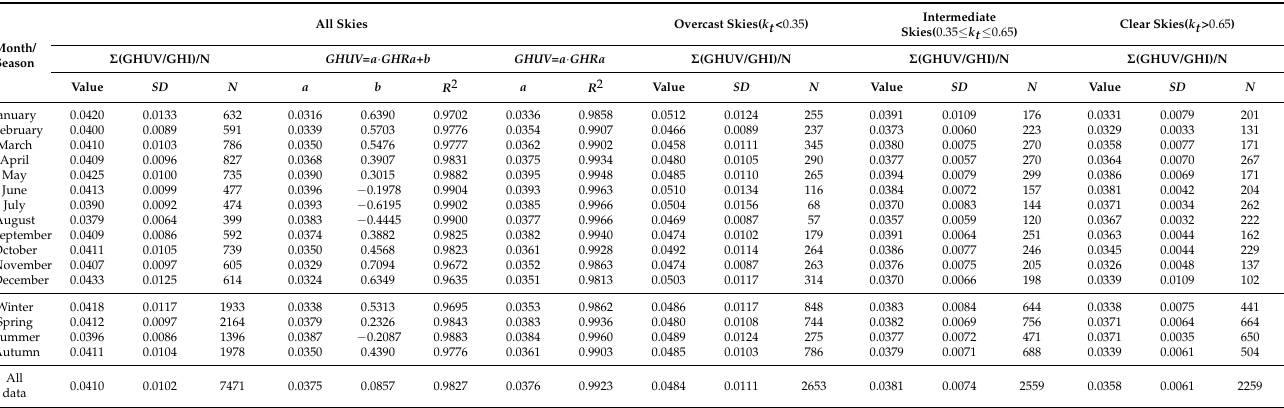
Table 8. Monthly, seasonal, and total GHUV/GHI average values, number of hourly values (N) and standard deviations (SD) under different sky conditions, together with the slope (a), offset (b), and R 2 values of the linear regressions GHUV = a · GHI + b and GHUV = a · GHI . AllSkies OvercastSkies( kt < 0.35 ) Intermediate Skies( 0.35 ≤ kt ≤ 0.65 ) ClearSkies( kt > 0.65